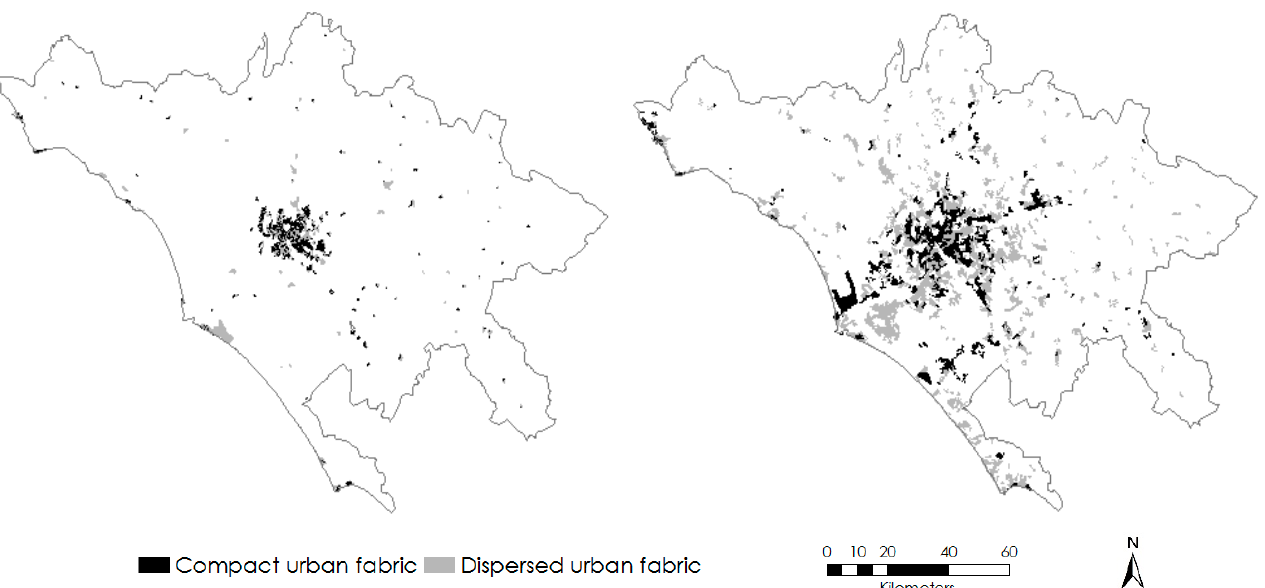
Figure 3. The spatial distribution of the compact and dispersed urban fabric in the study area in the early 1960s ( left ) and late 2010s ( right ), based on the elaboration on a local land cover map for 1960 and Corine Land Cover database for 2018.